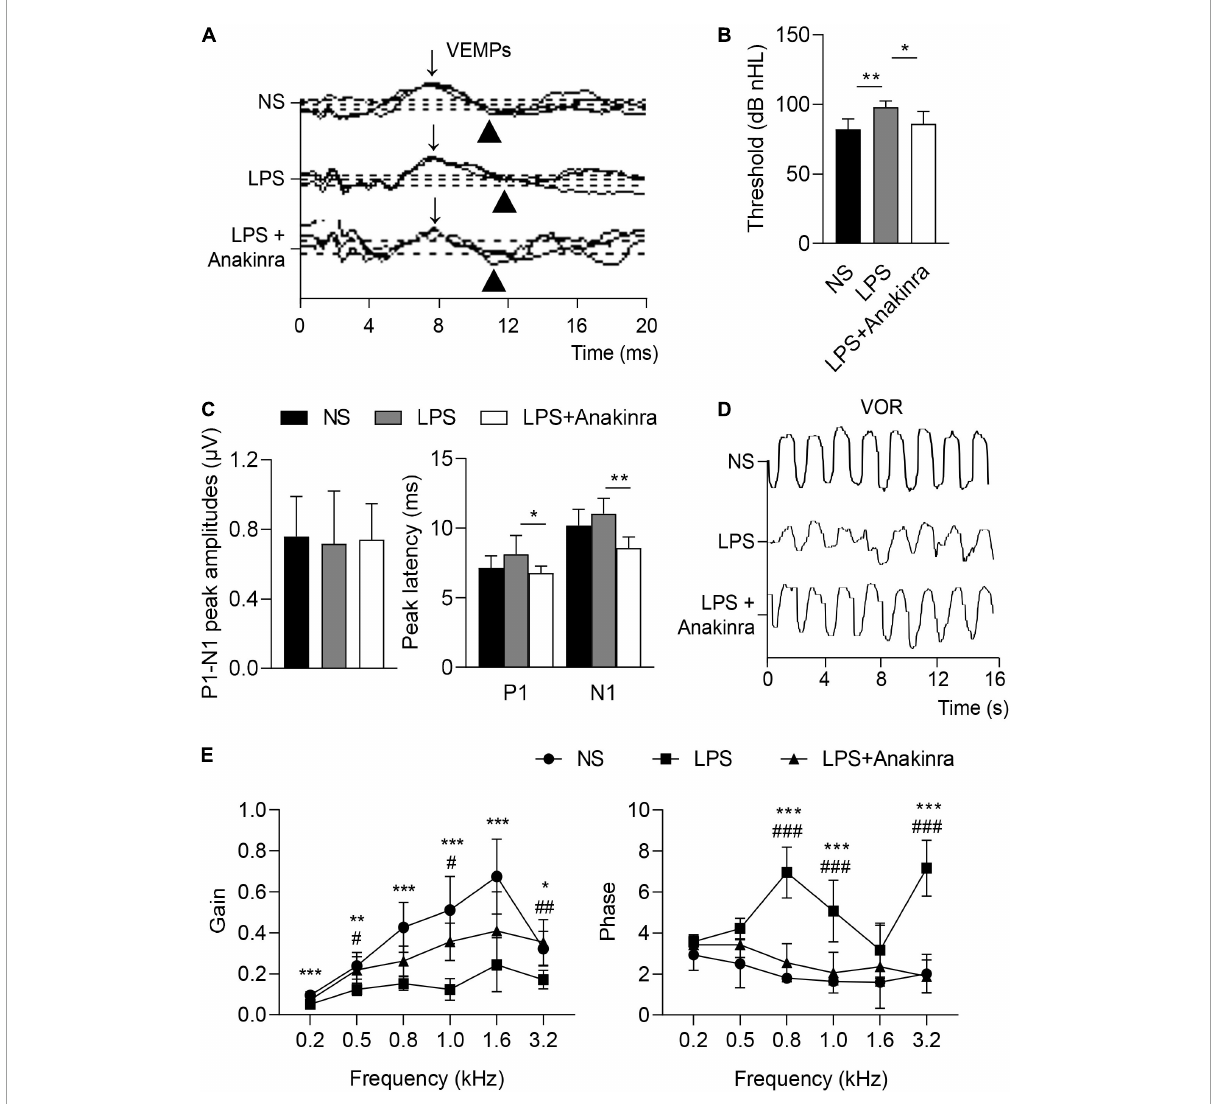
FIGURE3 Anakinra alleviated LPS-induced vestibular dysfunction in mice. (A) Representative click-evoked VEMPs waves, P1( ↓ ) and N1( (cid:78) ). (B) Changes in VEMPs threshold ( n = 5). (C) Changes in P1-N1 peak amplitudes, and the peak latencies of P1 and N1 at 100 dB nHL ( n = 5). (D) Representative horizontal VOR waves of all groups. (E) The VOR gains and phases are plotted for all groups at a peak velocity (20 ◦ /s) and frequencies range from 0.2 to 3.2 kHz ( n = 5, *NS group compared to LPS group, # LPS group compared to LPS + Anakinra group). Data are presented as mean ± SD. *or # p < 0.05, **or ## < 0.01 ***or ### p < 0.001. NS, 0.9% normal saline; VEMPs, vestibular-evoked myogenic potentials; P1, positive peak; N1, negative